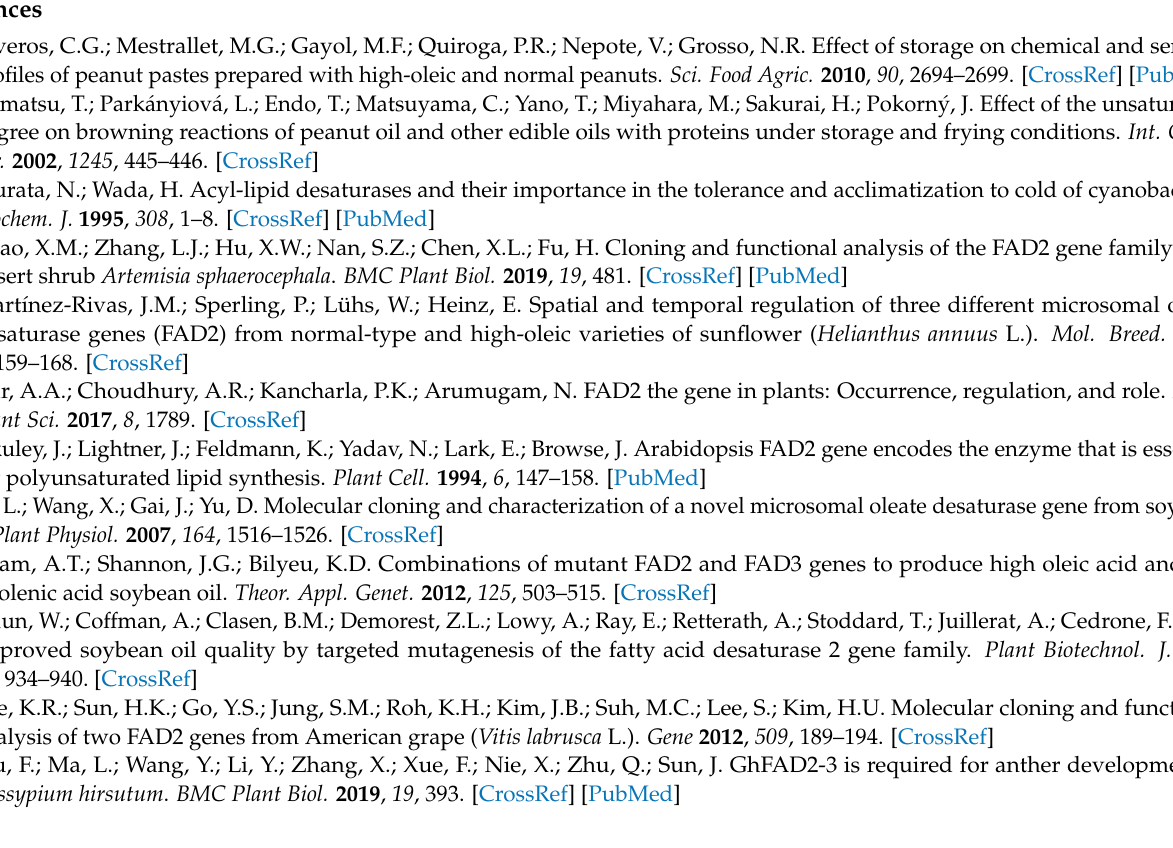
information of new members of FAD2. Table S3: Fatty acid composition of transformed INVSc1. Table S4: Determination of fatty acids in transgenic Arabidopsis